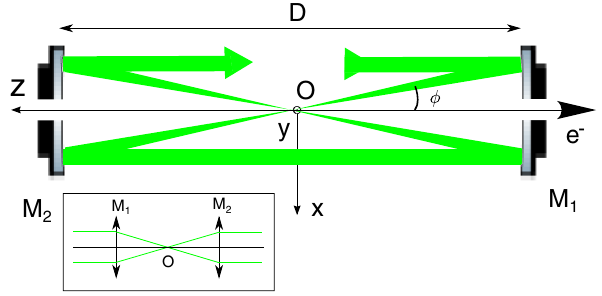
FIG. 1. Illustration of the principle of the planar confocal recirculator and its equivalent sequence of lenses. Note also the coordinate system used throughout this